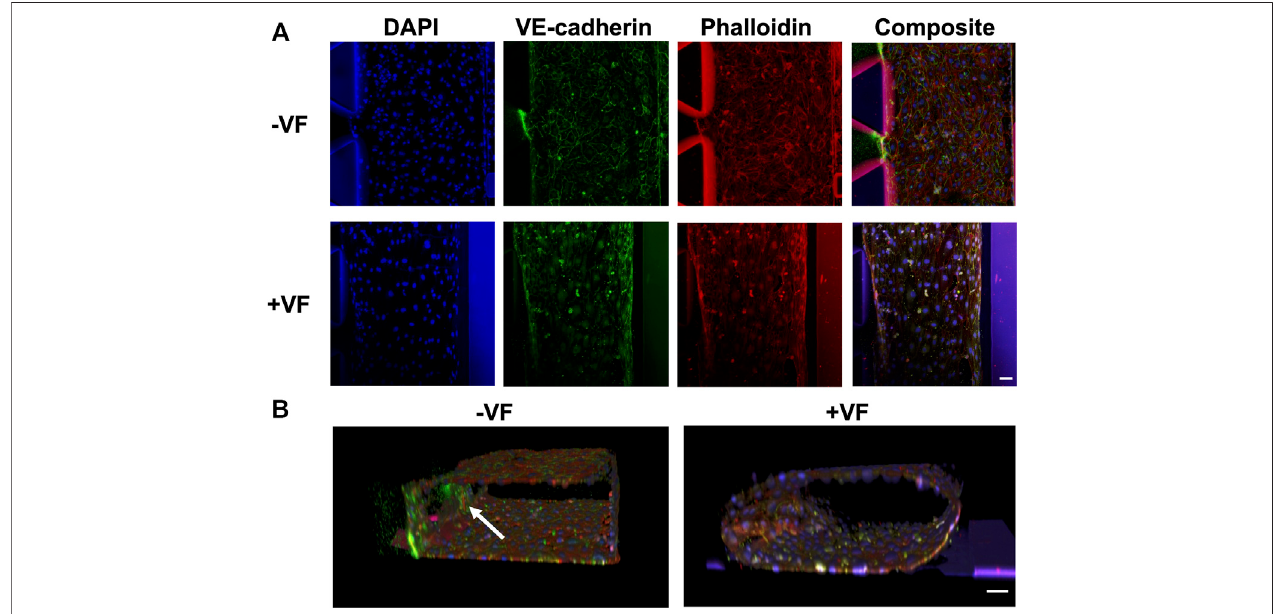
FIGURE7| Immuno fl uorescenceimagesofthevesselsformedwithorwithouttheVFcollagenlumenshowingnuclear(blue),VE-cadherin(green)andF-actin(red). (A) Comparison of the vessels formed without the VF method (cells grown on the plastic surface of the AIM biochip) or with the VF method (cells grown on the collagen lumen). (B) 3D rendering of HUVEC vessels formed without or with VF collagen lumen. A white arrow indicates the cells that grow on the fi brin gel. Scale bar: 50